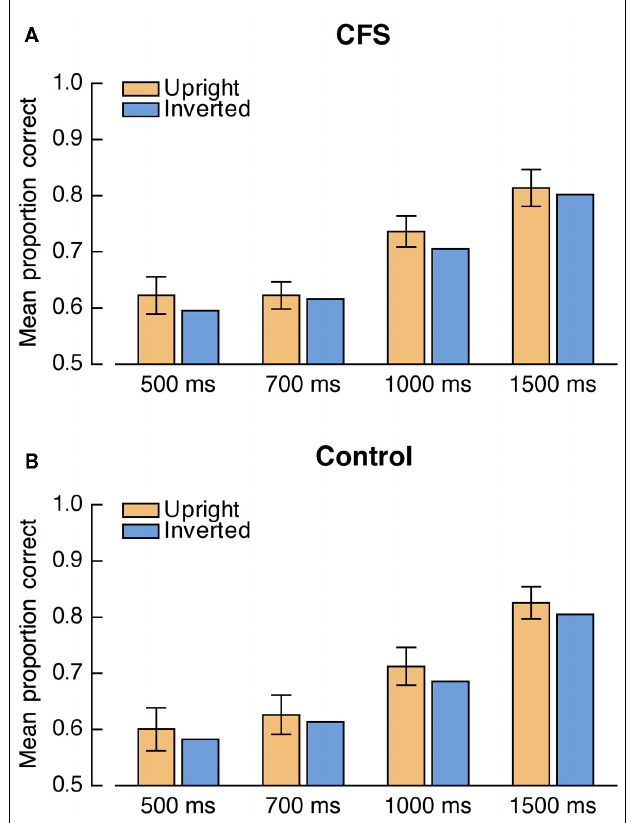
FIGURE 7 | Results from Experiment 3. Mean accuracies for upright and inverted faces, presented separately for (A) the CFS condition and (B) the control condition at each presentation duration. Error bars denote the 95% confidence interval for the paired comparison of upright and inverted faces at the respective presentation duration.